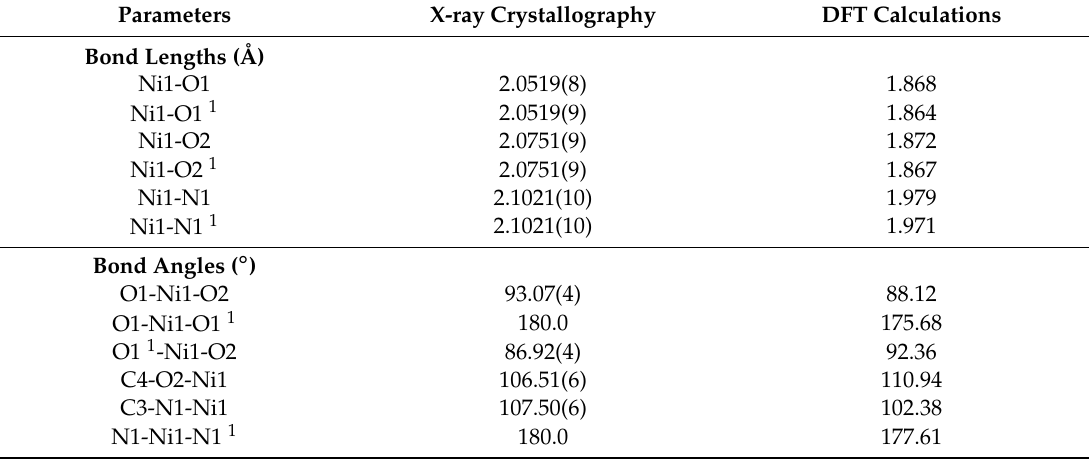
Table 4. Structural parameters of the Ni-TEA complex, which is experimentally derived from the SC-XRD data and theoretically obtained by the DFT